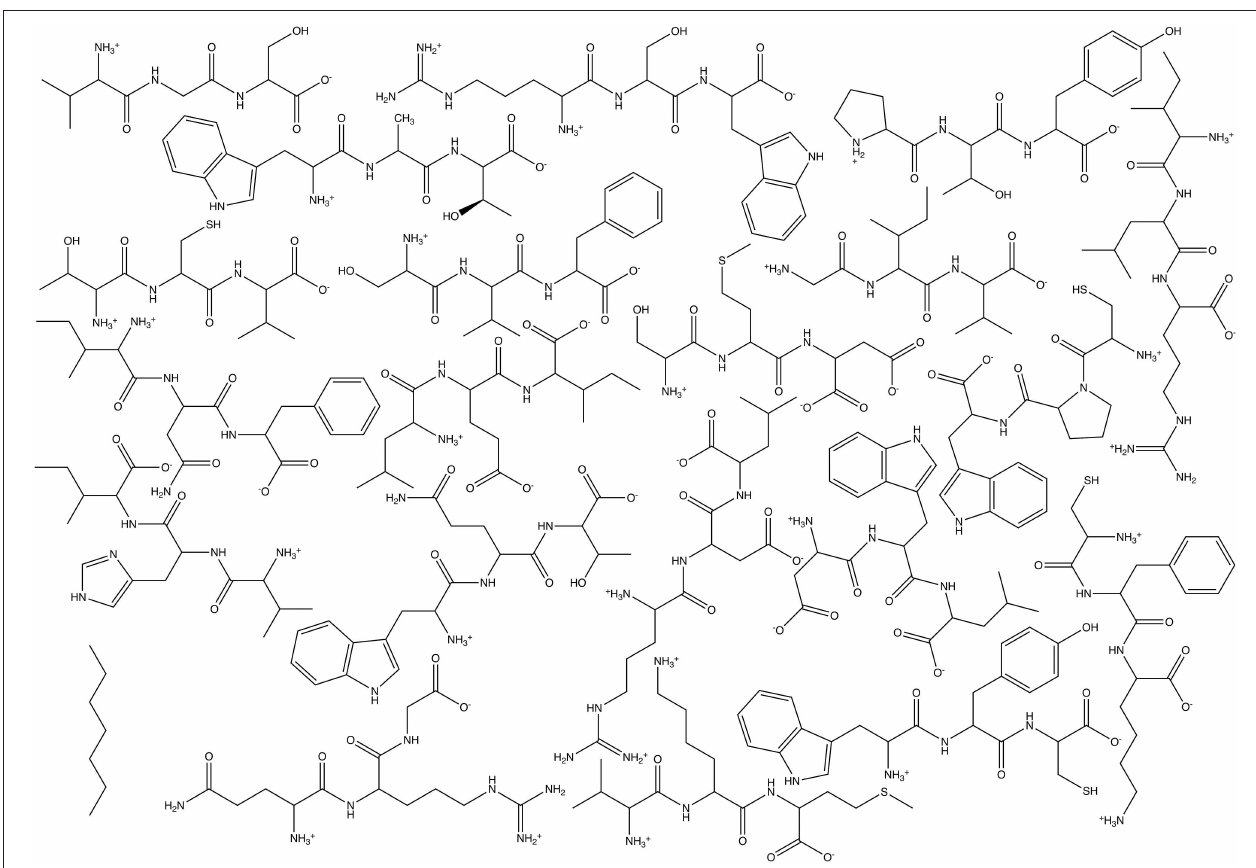
FIGURE 5 | Chemical structures of the molecules used to generate the two Athenaeums used here: 20 tripeptides plus heptane.